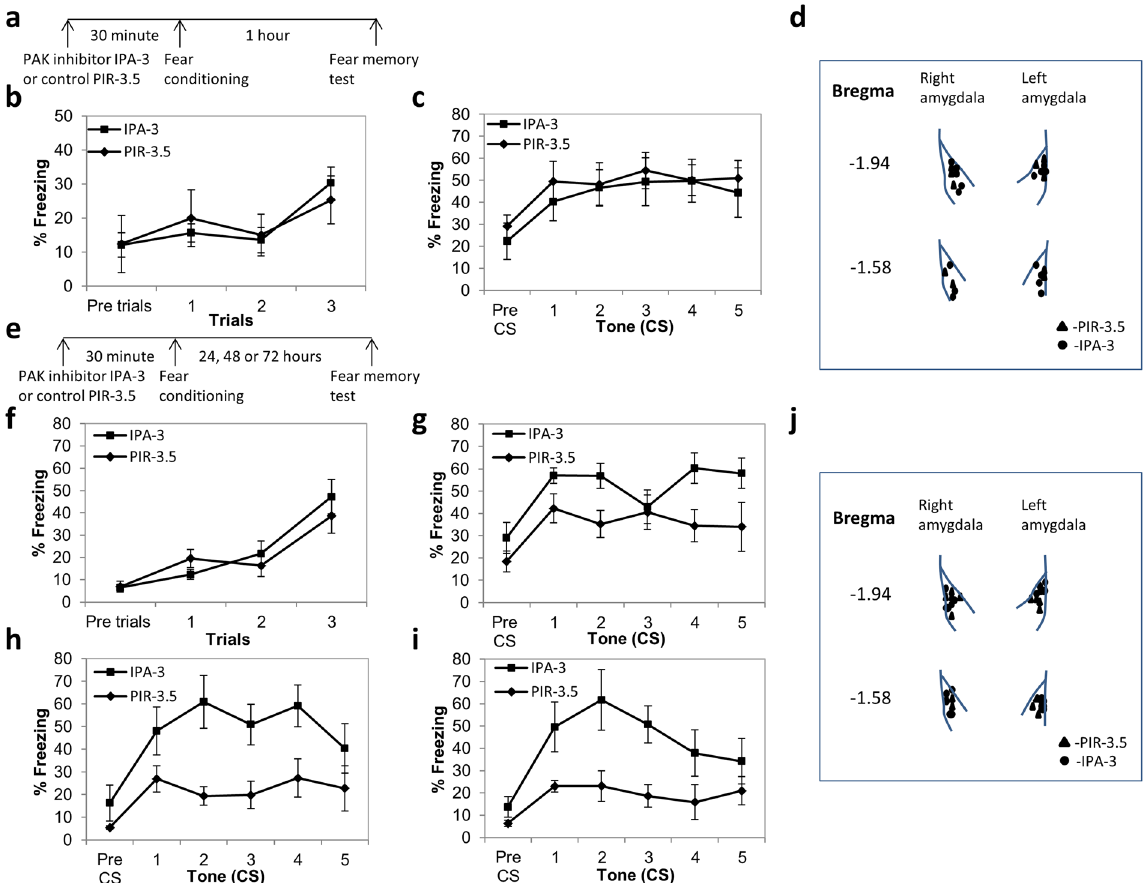
Figure 4. Inhibition of PAK activity in LA enhanced long-term, but not short-term, fear conditioning memory. (a) Schematic description of the short-term memory (STM) fear conditioning behavioral protocol. (b) Freezing during training was not different in animals to be tested for STM and microinjected with IPA-3 30 minutes before fear conditioning when compared to PIR-3.5 injected mice (F (1,19) = 0.002, p > 0.9). (c) Microinjection of IPA-3 into LA 30 minutes before fear conditioning (n = 12) had no significant effect on fear memory compared to PIR-3.5 microinjected controls (n = 9) when tested 1 hr after training (F (1,19) = 0.138, p > 0.7). (d) Cannulas placement in animals that participated in the STM test. (e) Schematic description of the long-term memory (LTM) fear conditioning behavioral protocol. (f) Freezing during training was not different in animals to be tested for LTM and microinjected with IPA-3 30 minutes before fear conditioning when compared to PIR-3.5 injected mice (F (1,14) = 0.089, p > 0.7) . (g) Microinjection of IPA-3 into LA 30 minutes before fear conditioning enhanced fear memory compared to PIR-3.5 microinjected controls when tested 24 hrs after training (F (1,14) = 4.885, p < 0.05) (n = 8 each). (h) Fear conditioning was enhanced in mice injected with IPA-3 into LA 30 minutes before training (n = 5) and tested 48 hrs after training when compared to PIR-3.5 microinjected mice (n = 6) (F (1,9) = 7.674, p < 0.03). (i) Fear conditioning was enhanced in mice injected with IPA-3 into LA 30 minutes before training (n = 5) and tested 72 hrs after training when compared to PIR-3.5 microinjected mice (n = 6) (F (1,9) = 6.812, p < 0.03). (j) Cannulas placement in animals that participated in the LTM